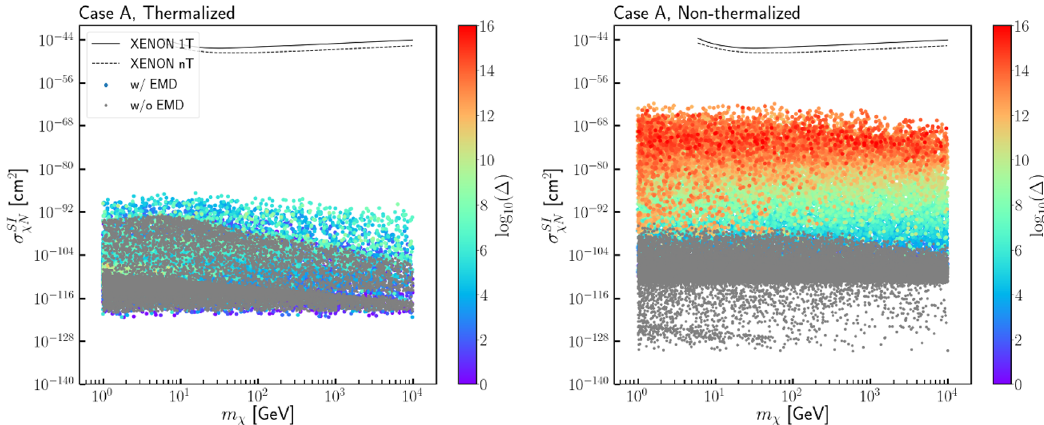
Figure 10 . The SI scattering cross section with nucleon with (color-coded points) and without (grey points) EMD era for Case A, as a function of the dark matter mass, m (cid:31) . Each point provides the observed DM relic density, under the freeze-in regime. The color bar indicates the value of the dilution factor (cid:1) (eq. (3.17)), with increasing values corresponding to longer EMD era scenarios. The heavy neutrino is considered to be thermalized (left panel) and non-thermalized (right panel) respectively. The solid and dashed lines represent current XENON-1T and prospected XENON-nT bounds,